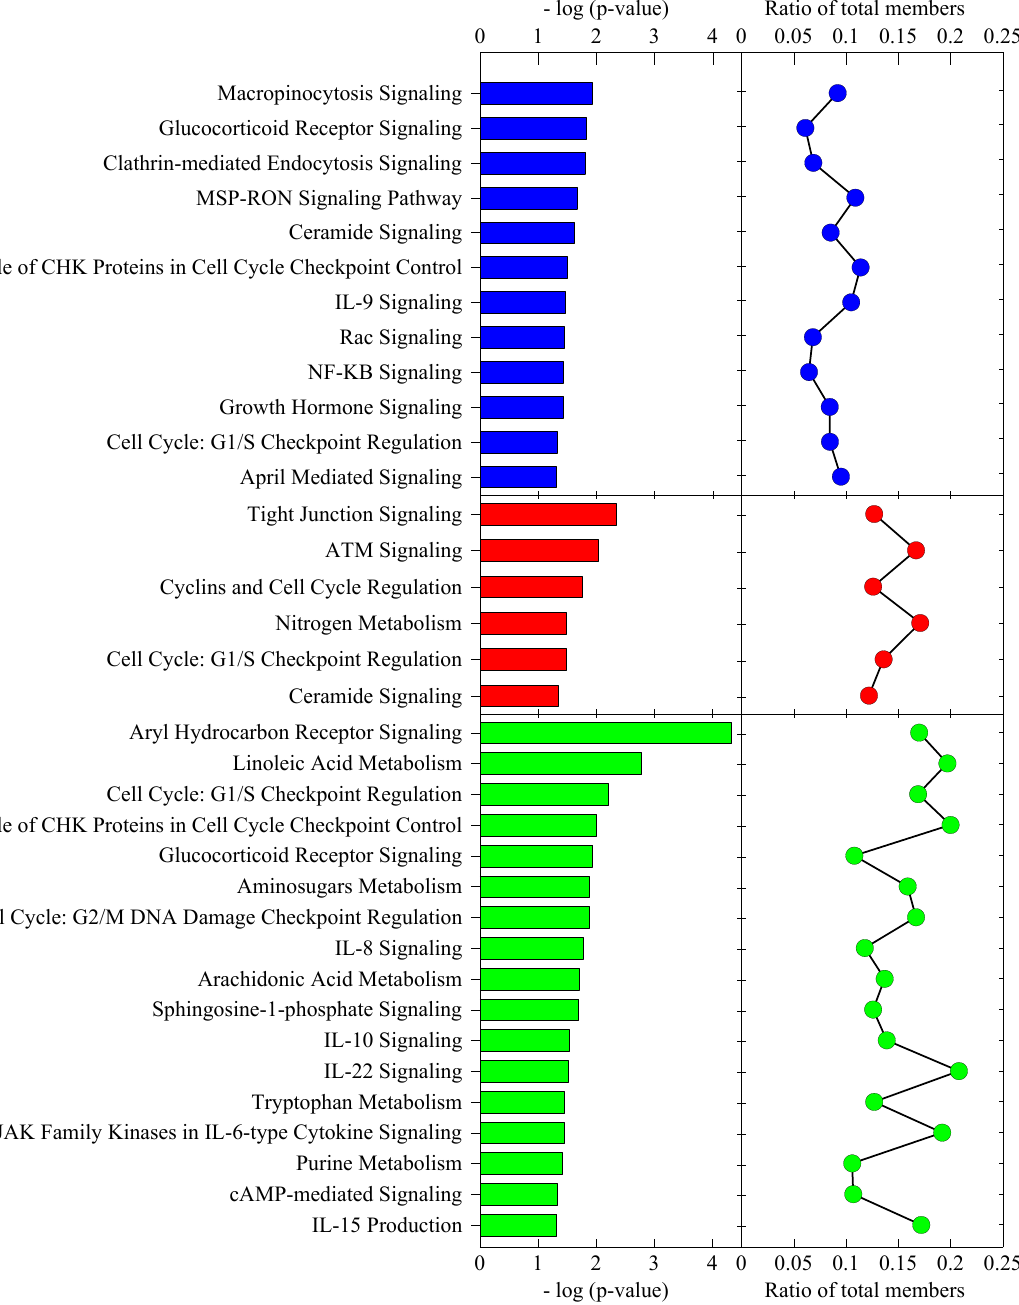
Figure 10. Classification of differentially expressed genes into various cellular stress response implicated canonical pathways. The [−log( p -value)] is the maximum p -value for all of the genes in each particular canonical pathway family. The ratio plot indicates the number of the genes expressed at each time point relative to the total number of genes in that particular canonical pathway